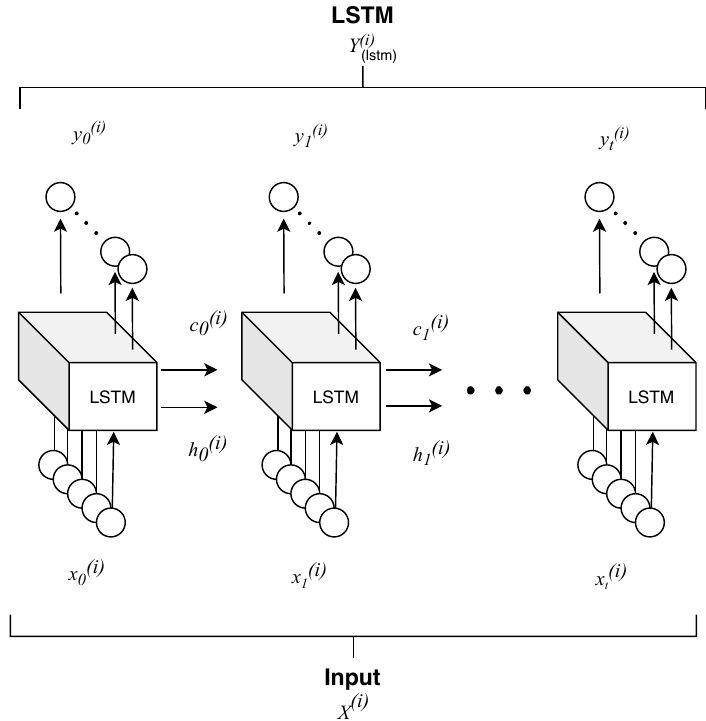
Figure 6. Pixel R-CNN first layer for time correlations extraction. Peephole LSTM cells extract temporal representations from input instances X ( i ) ∈ R t ∗ b . The output matrix Y TimeDistributedDense layer, that preserves the multidimensional nature of the processed data extracting multi-spectral